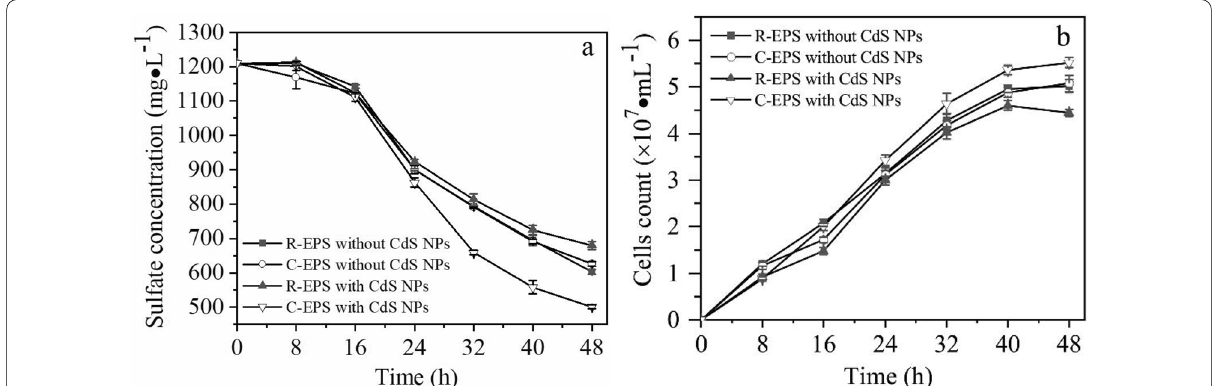
Fig. 4 Effects of CdS NPs on sulfate reduction, growth and EPS composition of strain. C09 that removed/contained EPS. a Sulfate concentration; b